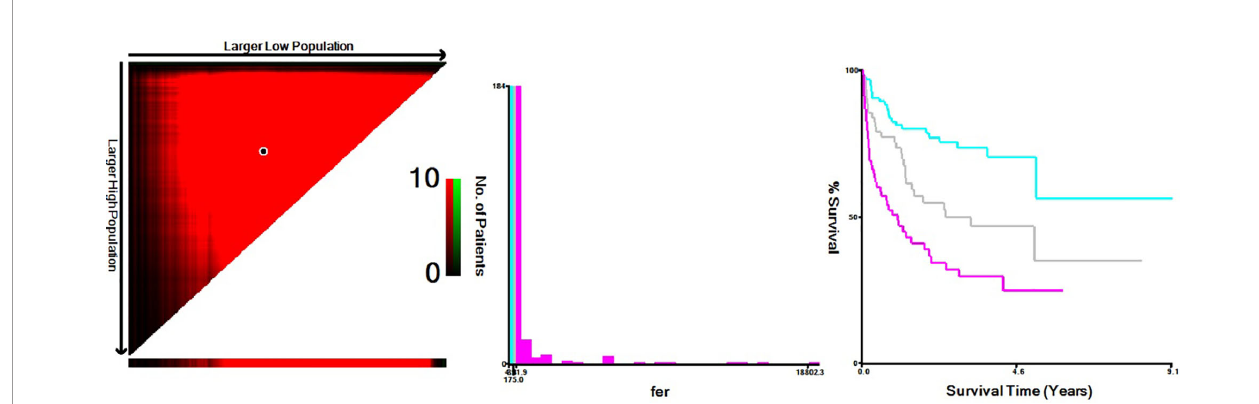
FIGURE 1 | X-Tile data are displayed in a right-angled triangle grid, where each point represents a different cut point. The intensity of the color at each cutoff point indicates the strength of the association. X-Tile analysis of survival data from DLBCL patients reveals a continuous distribution based on ferritin. The plots show the c2 log-rank values produced when dividing the patients with two cut-points, producing high, middle, and low